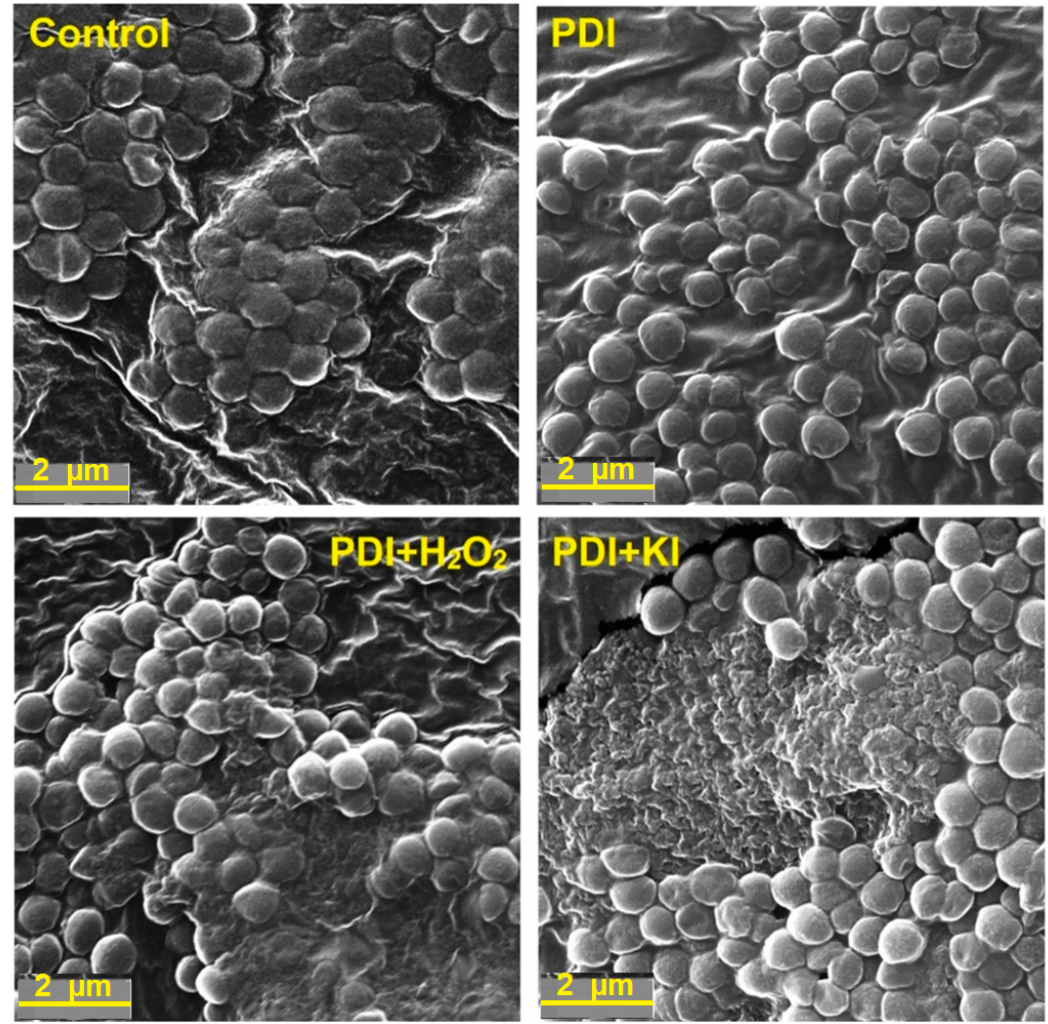
Figure 11. SEM images of Staphylococcus aureus before PDI treatment (control) and bacterial cell debris after different PDI procedures (2 h incubation, 10 J/cm 2 , 420 ± 20 nm LED light, material concentration at 0.5 g/L with addition of 100 mM H 2 O 2 or 100 mM KI).